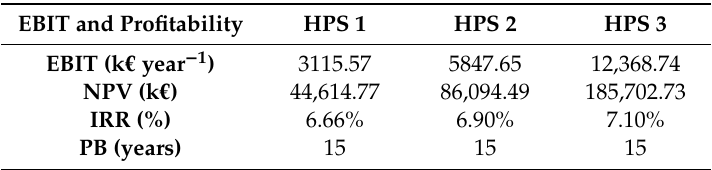
Table 4. Profitability analysis of HPS 1, HPS 2 and HPS 3, making use of existing infrastructure and considering DTCs of 8 h and a lifetime of 35 years.